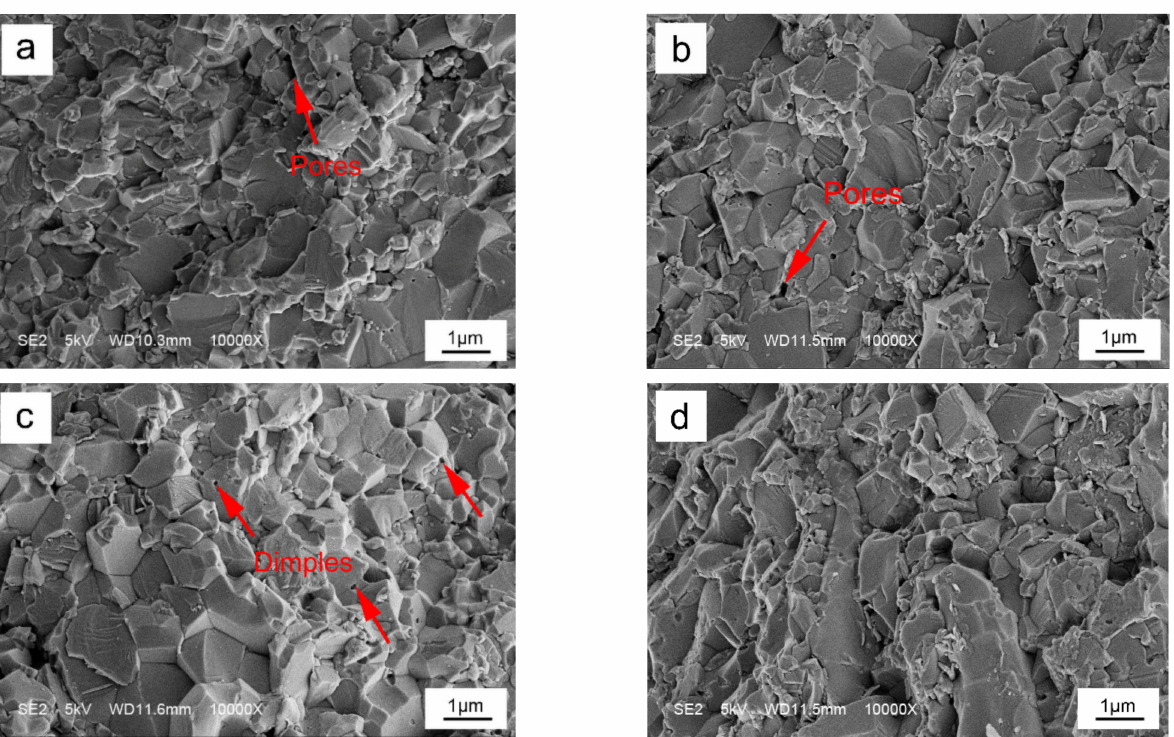
Figure 4. The microstructures of fracture surface of Al 2 O 3 /TiC/TiB 2 ceramic tool materials with different TiB 2 content ( a ) Al 2 O 3 /TiC, ( b ) Al 2 O 3 /TiC/5 vol.% TiB 2 , ( c ) Al 2 O 3 /TiC/10 vol.% TiB 2, and ( d ) Al 2 O 3 /TiC/15 vol.% TiB 2